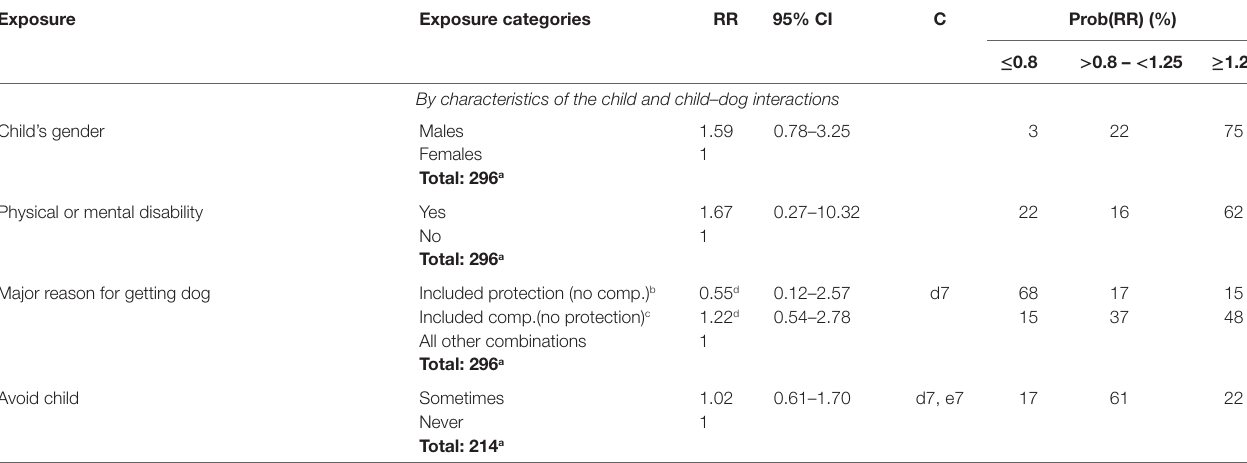
TaBle 4 | Adjusted relative risks (RRs), 95% confidence intervals (CIs), confounders (C) causing ≥ 10% change in RRs, and probabilities that population RRs [Prob(RR)] lie in the given range, for associations between selected variables and family dog-family child bite incidents, Kingston (KGN), Jamaica, and San Francisco (SF), USA.